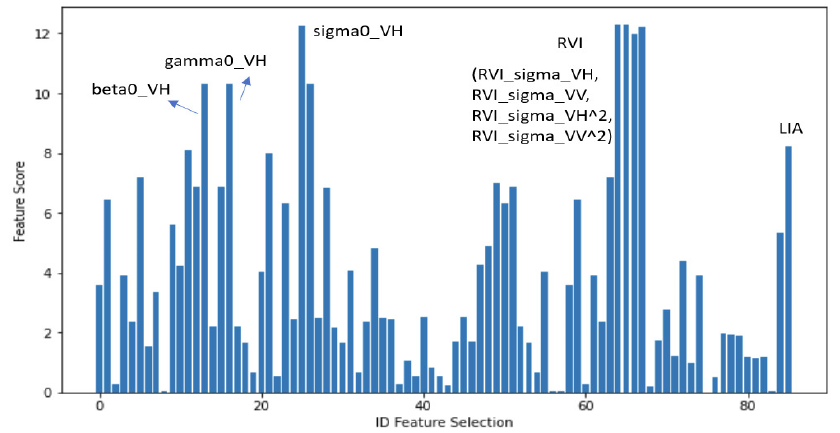
Figure 6. The feature scores obtained in hyperparameter tuning.